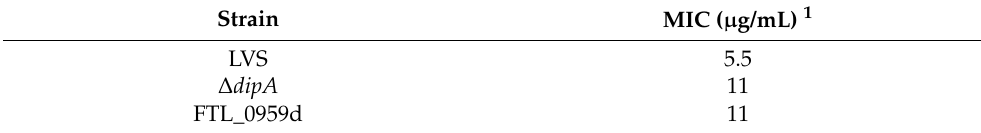
Table 4. MIC of resazurin for dipA and pilD F. tularensis LVS mutants. Strain